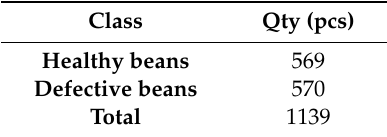
Table 2. Quantities from the experiment.